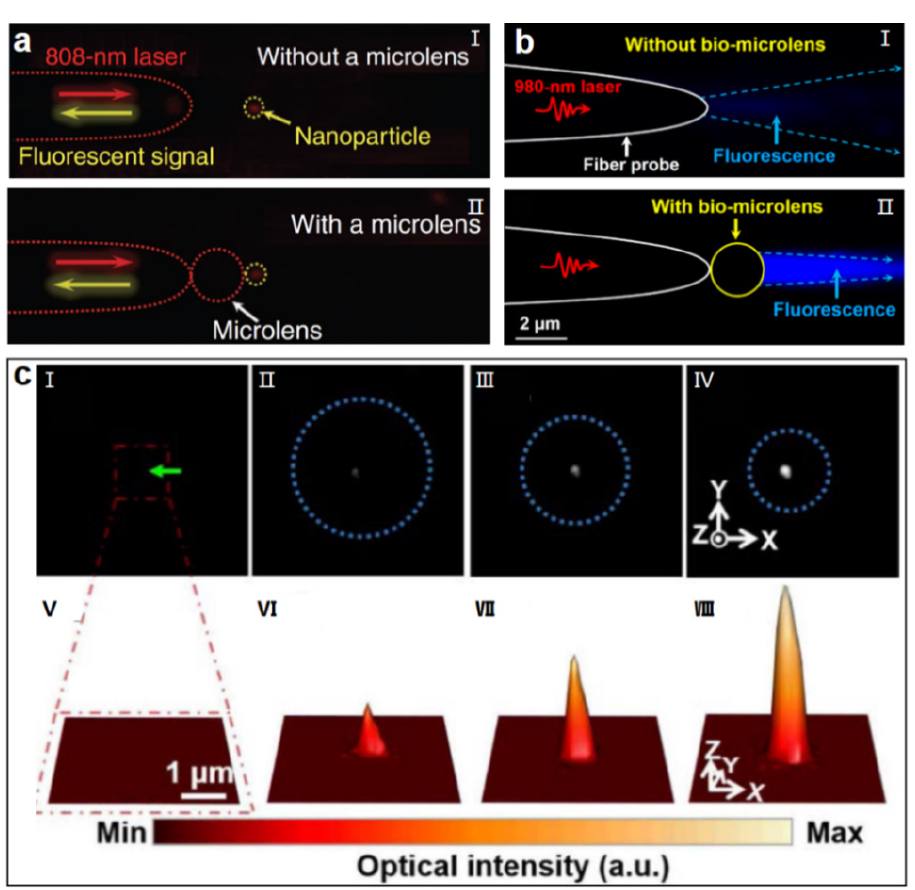
Figure 4. Fluorescence signal enhancement of microsphere superlenses. ( a ) Fluorescence signal images of the fiber without ( Ι ) and with (II) microlens for the sensing of individual nanoparticles; ( b ) Fluorescent image of the UCNP solution with fiber probe without ( Ι ) and with (II) biological microlens; ( c ) Fluorescence images of quantum dots with different diameters of C 10 H 7 Br microlenses using optical tweezers.